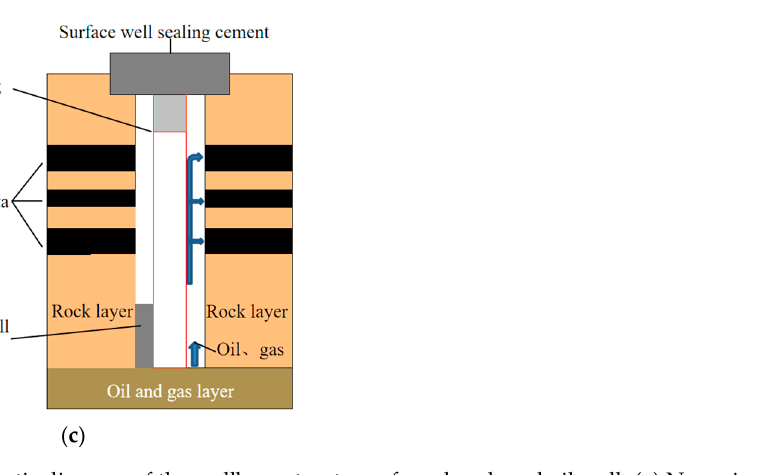
Figure 4. Schematic diagram of the wellbore structure of an abandoned oil well. ( a ) No casing (open hole); ( b ) Broken casing; ( c ) Reinforced wells are not toghtly sealed by ceme.